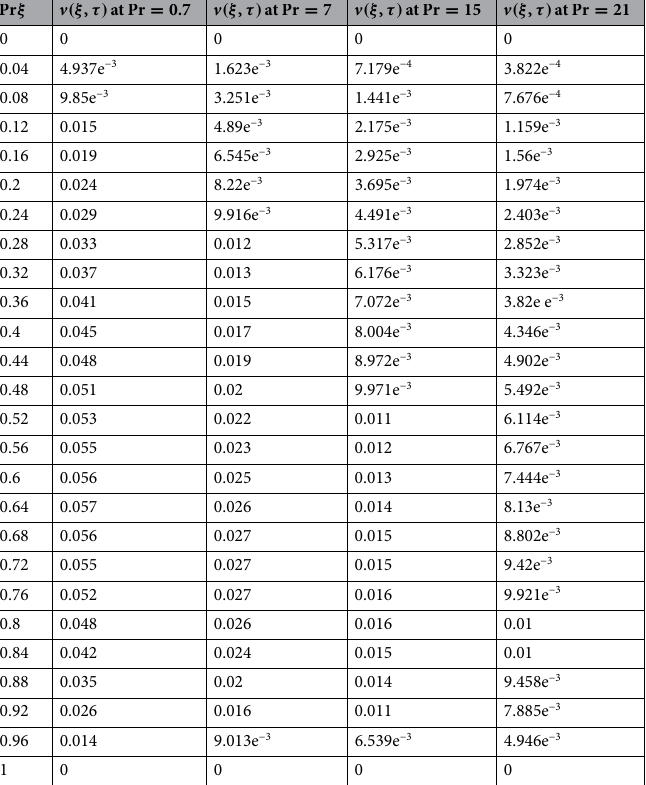
Table 7. Variations in velocity profile against if for different values of.